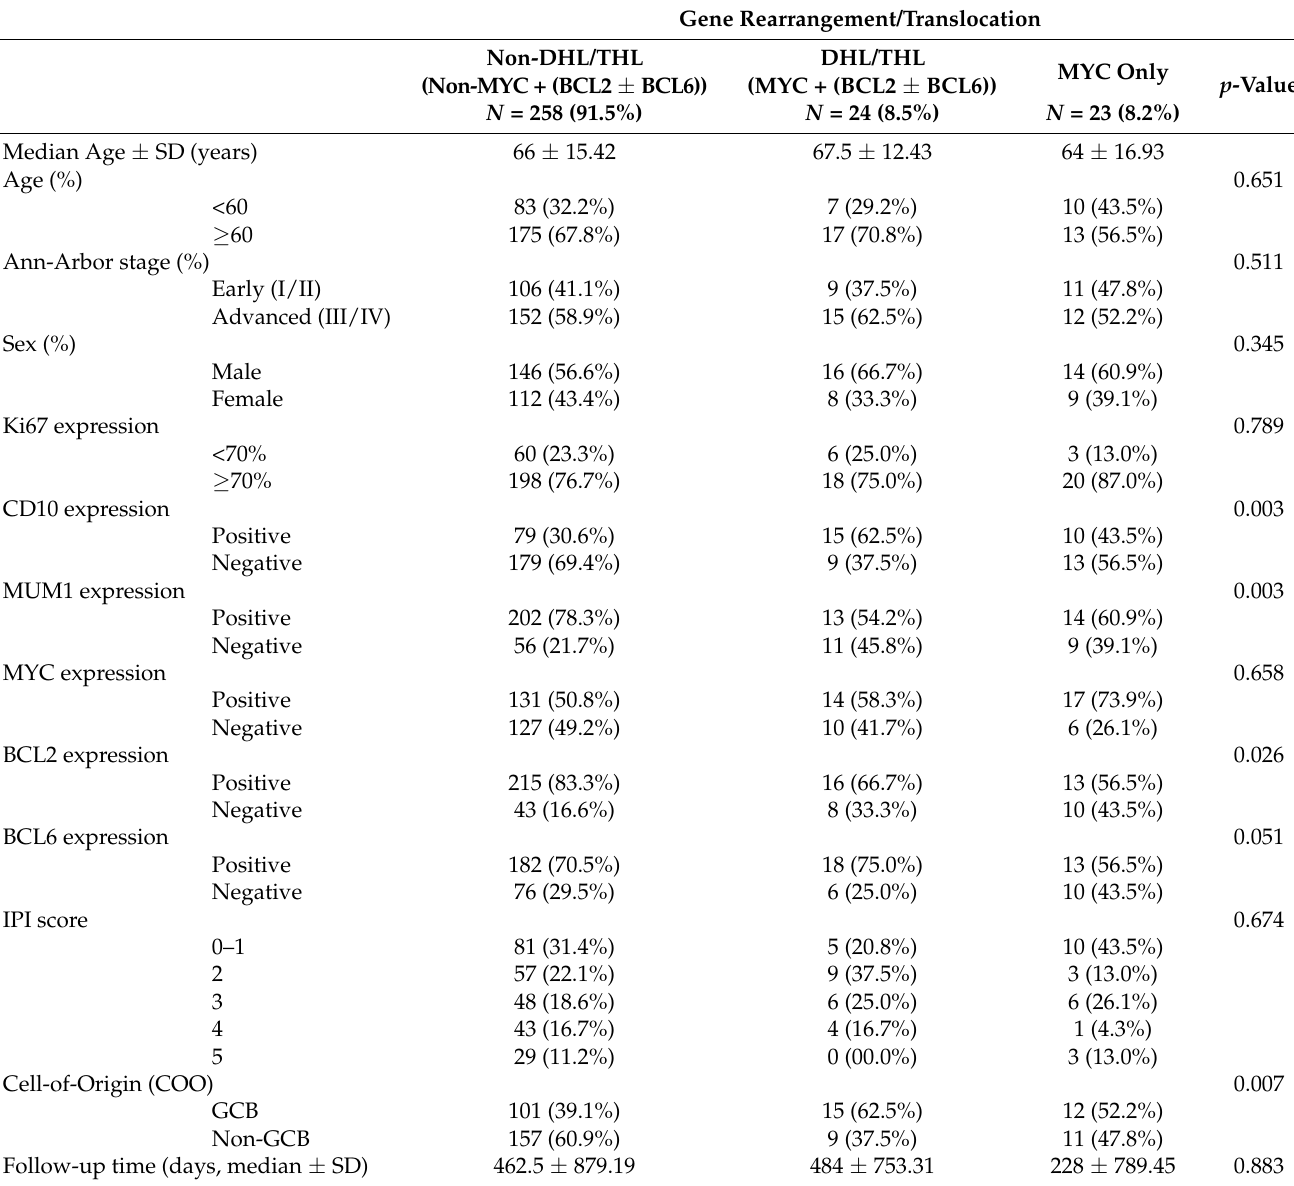
Table 1. Clinicopathological characteristics of our DLBCL cohort ( n = 282) based on the presence or absence of gene rearrangement. Gene